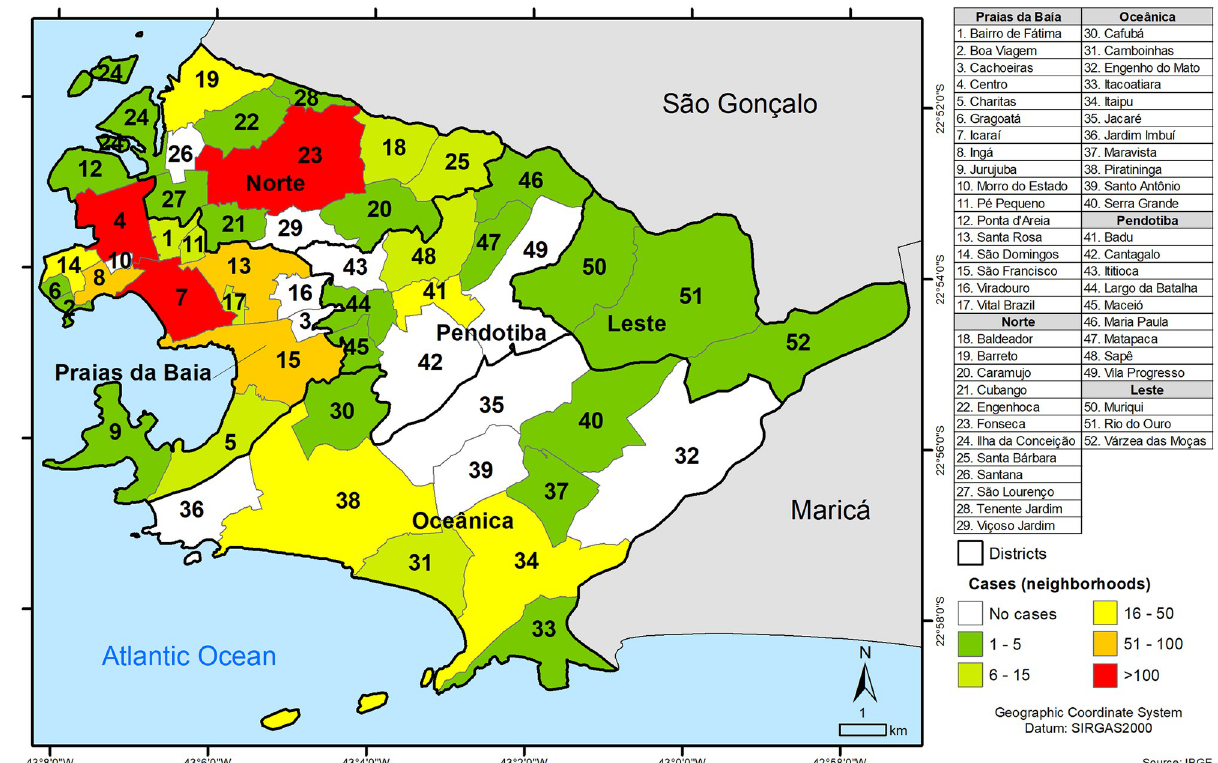
Fig 2. Districts and neighborhoods where patients with dermatophytosis from Nitero´i reside (https://www.ibge.gov.br/en/geosciences/ downloads-geosciences.html).